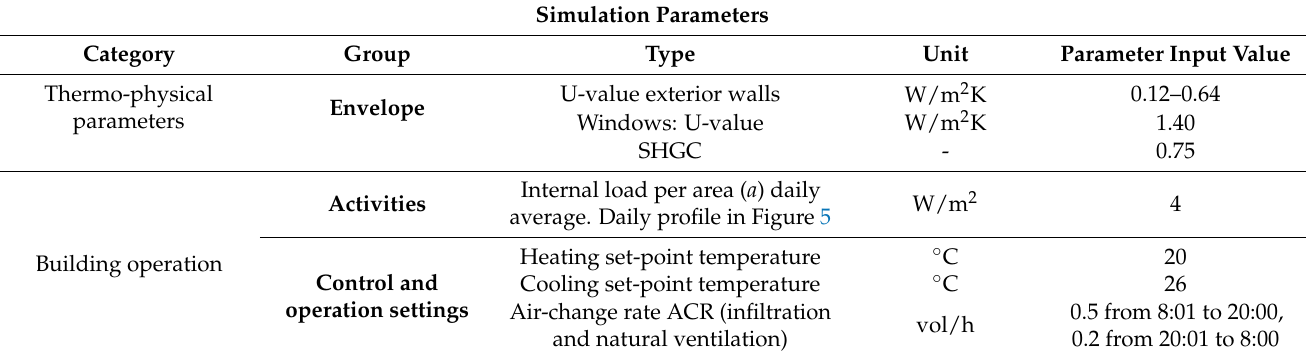
Table 2. Building energy model’s thermo-physical and operational